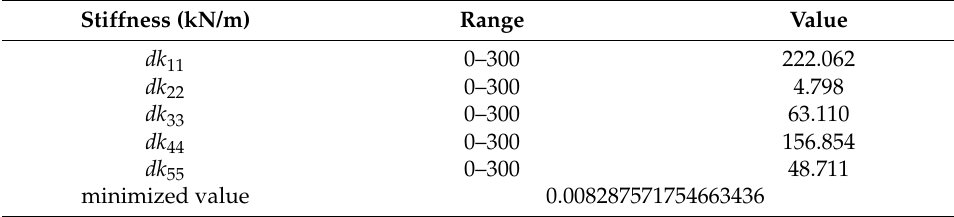
Figure 12. Modified structure after adding supporting stiffness. Table 7. Parameters of added supporting stiffness.